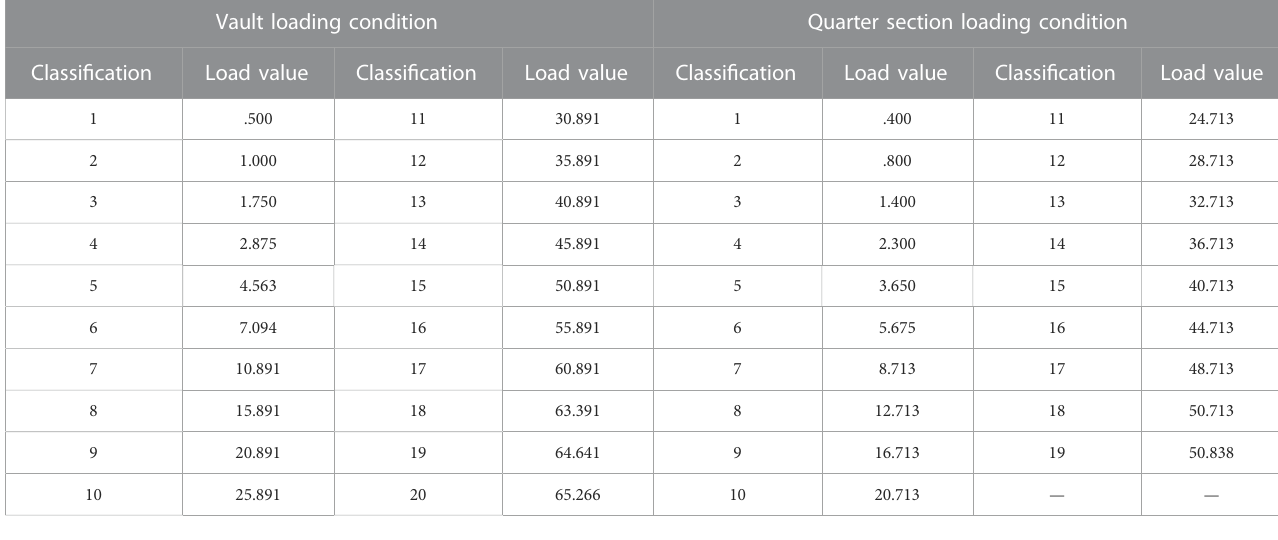
TABLE 3 Hierarchical loading value (Unit: kN).